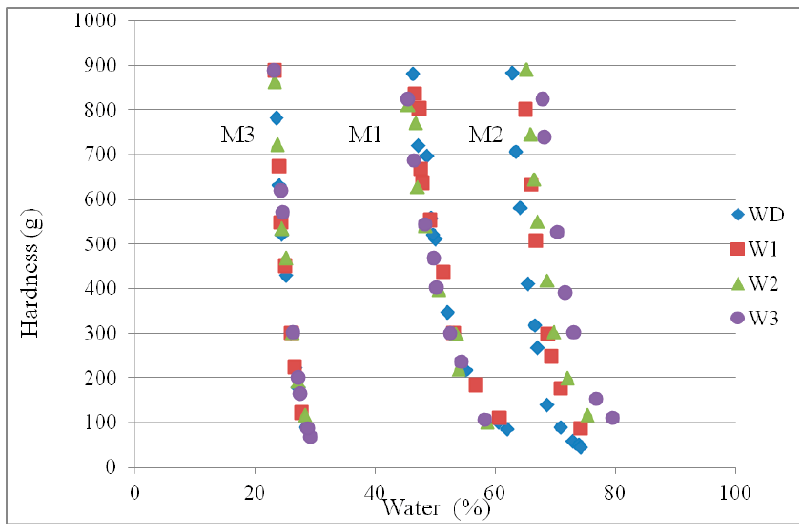
Figure 4. Hardness variations with water (%)